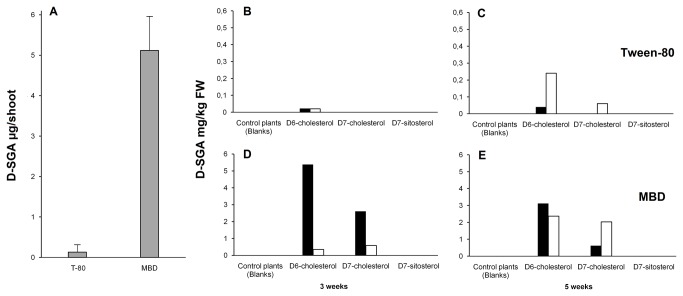
Formation of deuterium (D) -labelled SGA in potato shoots after feeding with D-labelled sterols solubilised in Tween-80 or methyl-β-cyclodextrin (MBD).Cut potato shoots (cv. King Edward) were fed 200 µg D6- cholesterol, D7-cholesterol, or D7-sitosterol solubilised in Tween-80 or MBD, and incubated during either three or five weeks. After the incubation period, the levels of D-SGA (α-solanine and α-chaconine) were analysed in upper leaves (black bars) and lower leaves (white bars) using LC-MS/MS. (A) Graphical illustration of the difference between Tween-80 (T-80) and MBD feedings. Mean value ± SD for the amount of D-SGA formed in leaves up to 5 weeks. A difference between the treatments (n=4 full plants each) was significant at p<0.001 (paired Student's t-test). (B) to (E) individual analyses, each representing a single analysis of materials from 2-3 pooled plants: (B) Tween-80, 3 weeks; (C) Tween-80, 5 weeks; (D) MBD, 3 weeks; (E) MBD, 5 weeks. Note the different scales for Tween-80 and MBD. No D-SGA was formed in parallel analyses of blank controls, or shoots fed D7-sitosterol.